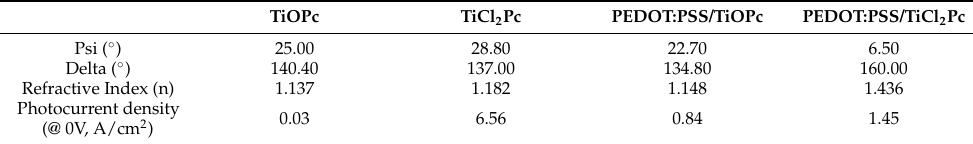
Table 5. Optical and electrical properties for the TiOPc and TiCl 2 Pc films and devices. TiOPc TiCl 2